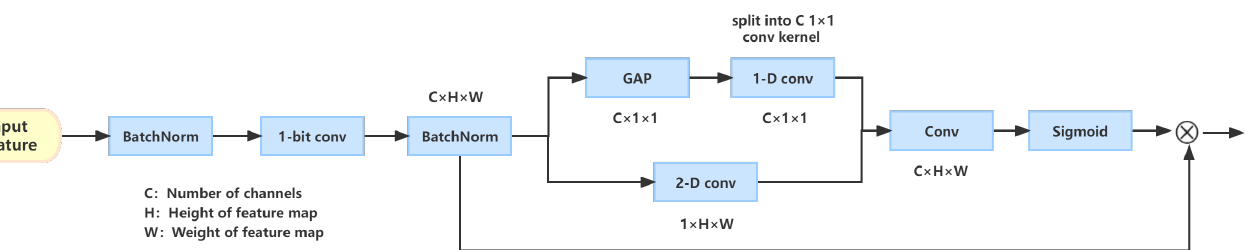
Figure 4. The calculation process of dynamic scale factor. We combine the calculation of two different dimensions of channel and space to obtain the dynamic scale